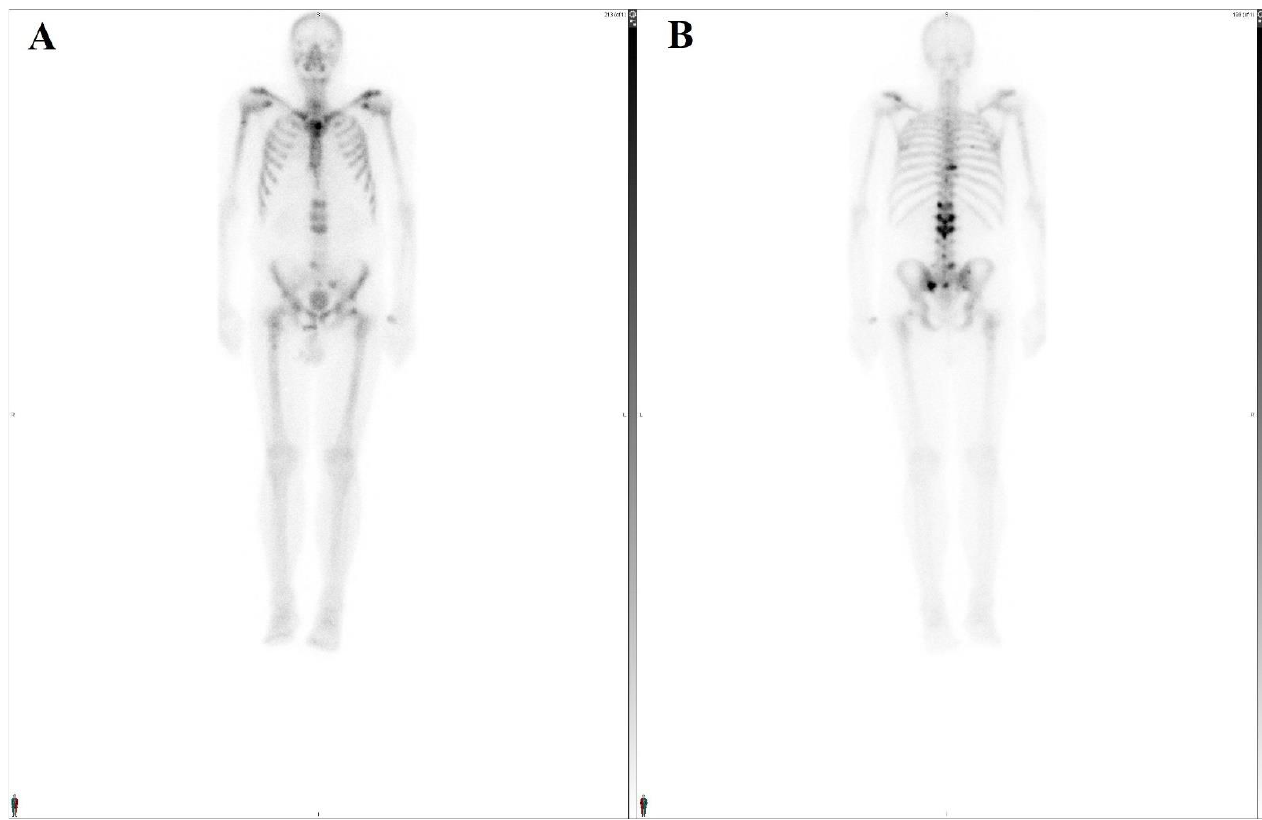
Figure 3. Anterior ( A ) and posterior ( B ) planar views of a whole-body bone scan show multiple radiotracer avid bone metastases at both axial and appendicular skeleton, most located at the